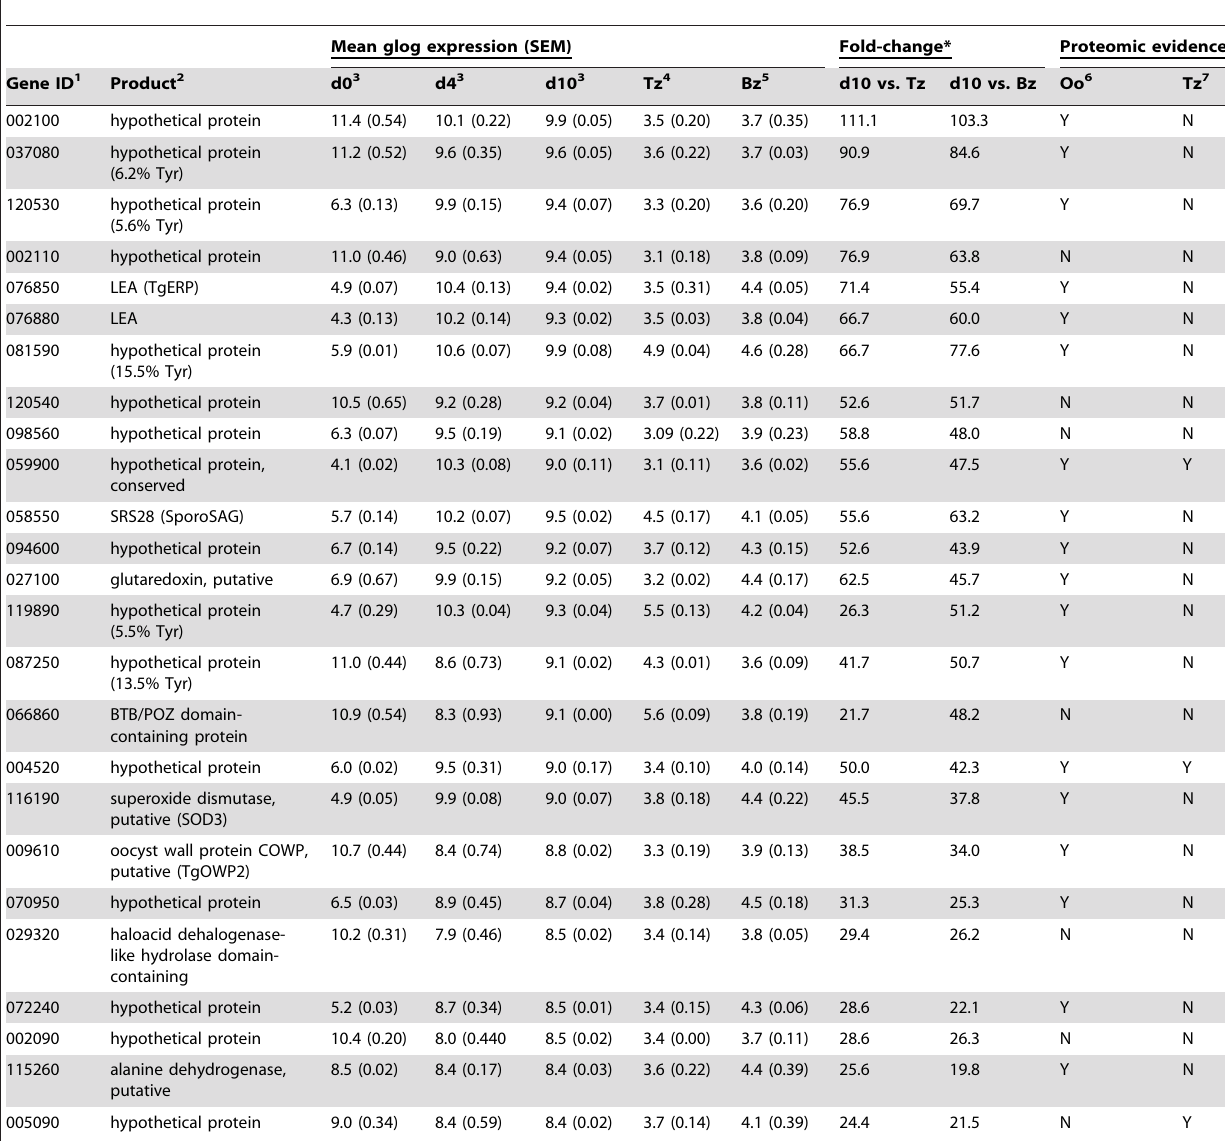
Table 3. Top 25 genes with significantly higher expression in day 10 oocysts compared to tachyzoites and bradyzoites, with day 0 and 4 oocysts included for